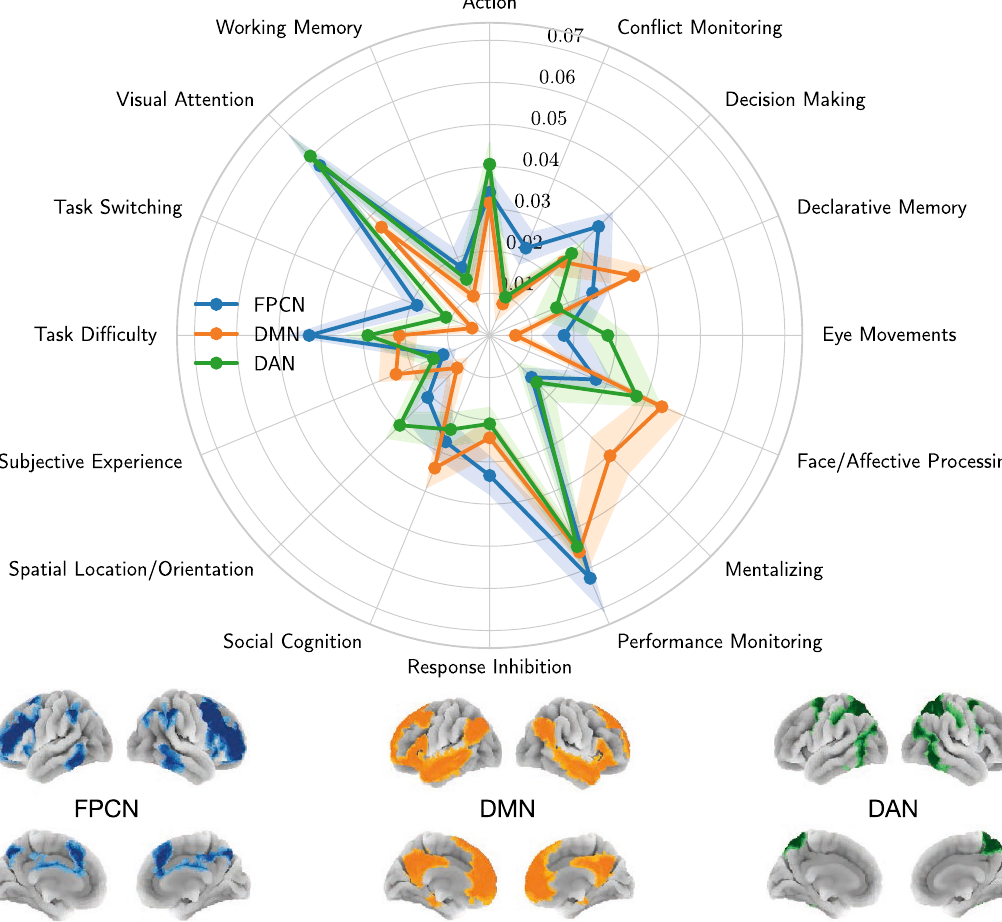
Figure 2. Functional profiles obtained with network-based segregation queries that identify the most probable topic associations in studies reporting activations within one network but not reporting activations within any of the other networks. A 95% confidence interval is depicted, across 1000 random 50% sub-samples of the Neurosynth database 3 . The three networks are depicted in the bottom panel of the